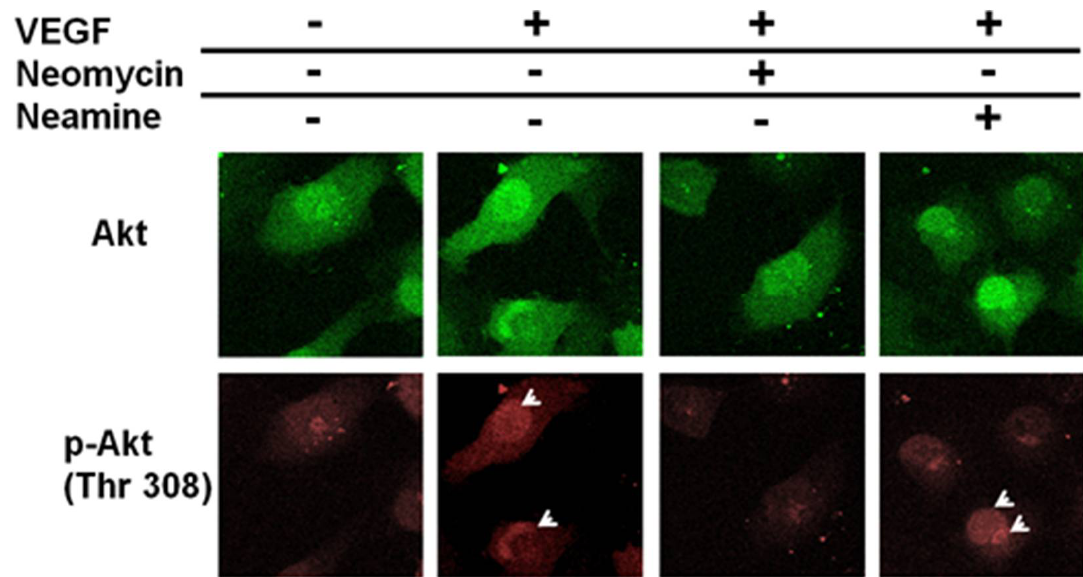
Figure 4. Confocal imaging of Akt activation. The images obtained for Akt are shown in green (top row), the ones obtained for its phosphorylated form on the threonine 308 residue, p-Akt, in red (bottom row). Neomycin and neamine were used as inhibitors. The white arrows indicate the sites where a high level of p-Akt is observed, in comparison to the control case.